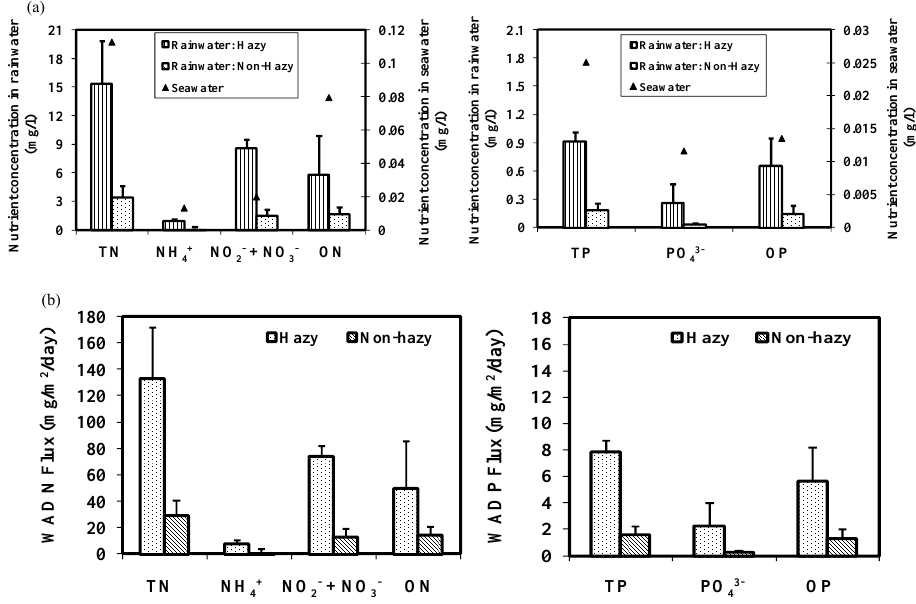
Fig. 6. (a) Concentration of nutrients (N and P species) in rainwater during hazy and non-hazy days and seawater; (b) Fluxes of nutrients (N and P species) in WAD during hazy and non-hazy days.